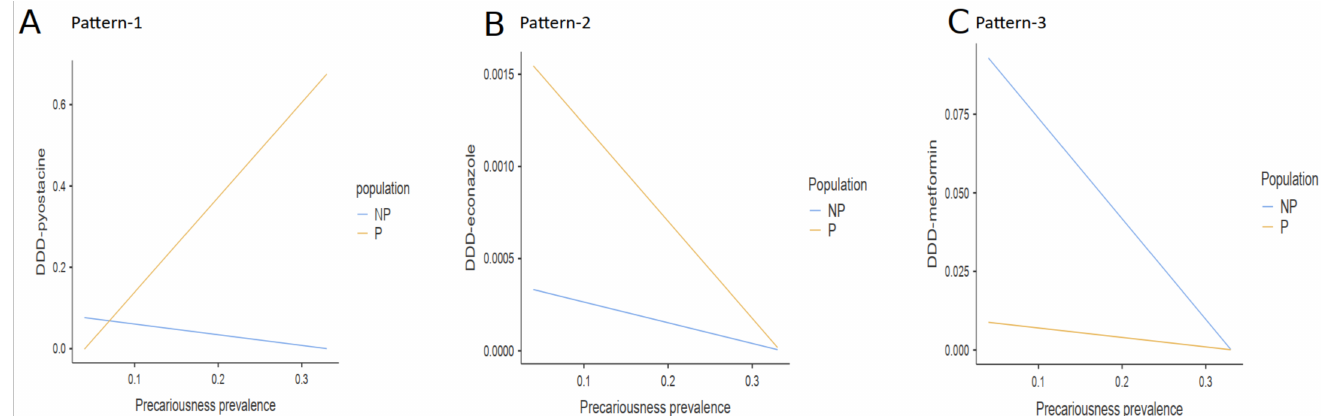
Figure 1. Interaction effects between precariousness prevalence and population on the DDD. There was a significant interaction effect between precariousness prevalence and population on the DDD, distributed into three different patterns. ( A ) In pattern-1, the more the precariousness prevalence increased, the more the DDD increased for rivaroxaban, rosuvastatin, Serenoa repens, tamsulosin, pyostacine, tiotropium, and timolol selectively in precarious populations. The DDD slightly decreased in non-precarious populations (data are shown for pyostacine). ( B ) In pattern-2, the more the precariousness prevalence increased, the more the DDD decreased for econazole and cromolyn sodium in precarious populations (data are shown for econazole). ( C ) In pattern-3, the more the precariousness prevalence increased, the more the DDD decreased for metformin and atorvastatin in both non-precarious populations (data are shown for metformin) (Note: NP = non-precarious; P = precarious; DDD = defined daily